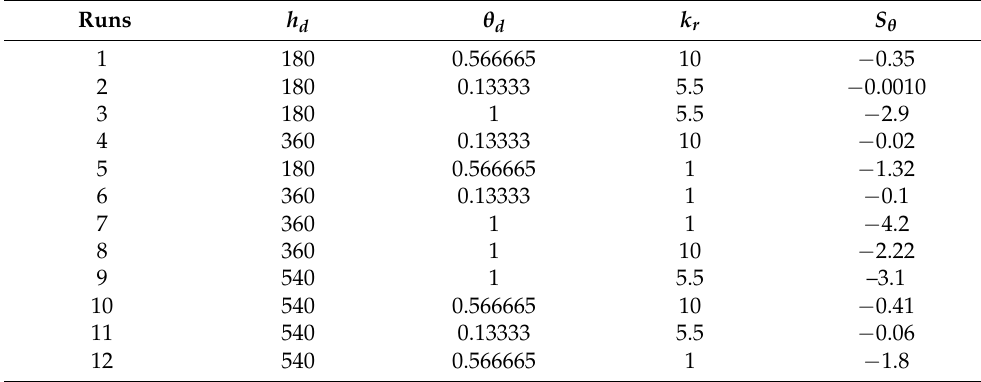
Table 3. Twelve numerical runs and the results of skin